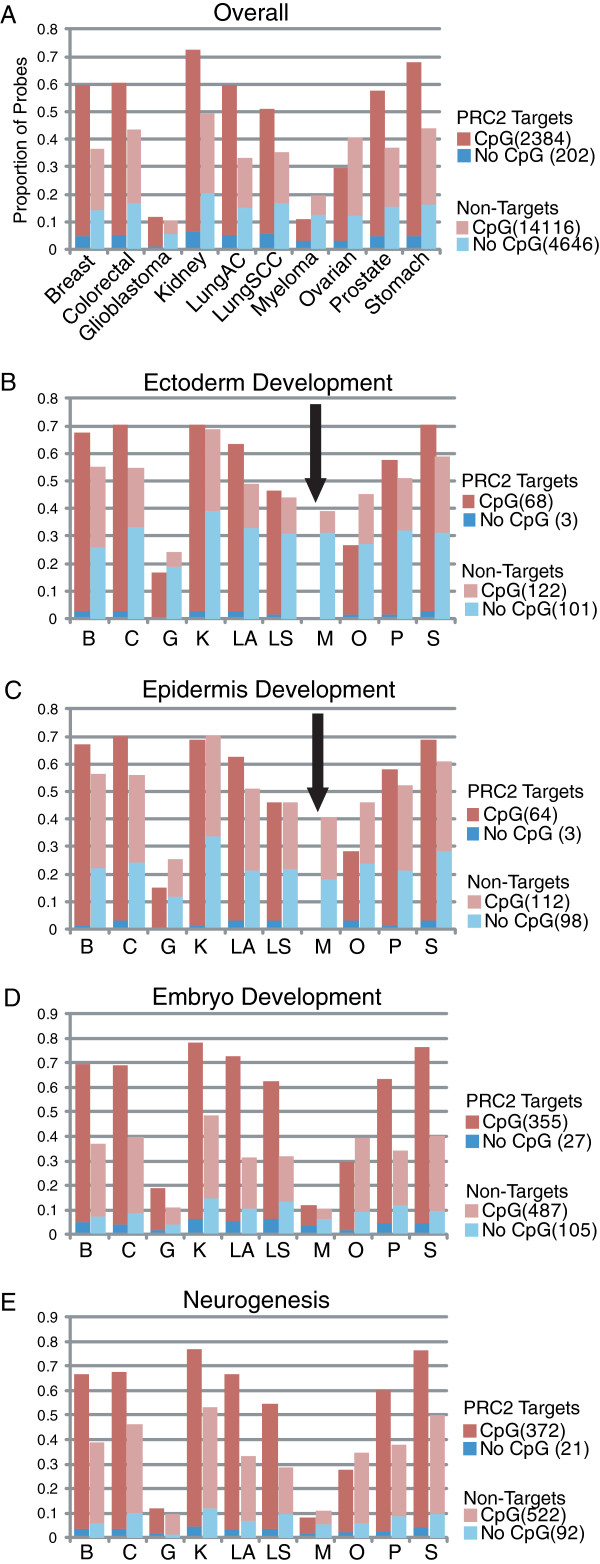
The percentage of PRC2 target vs. non-target genes harbouring significant (p-value<0.05) differential methylation. The significant differentially methylated genes from a select few developmental concepts including dermal, embryo, and neural development were subjected to further analysis with respect to PRC2 targets and the presence of CpG islands. As reported, a higher proportion of PRC2 target genes was differentially methylated in multiple tumor types. Interestingly, none of the PRC2 target genes involved in dermal development were differentially methylated in multiple myeloma.